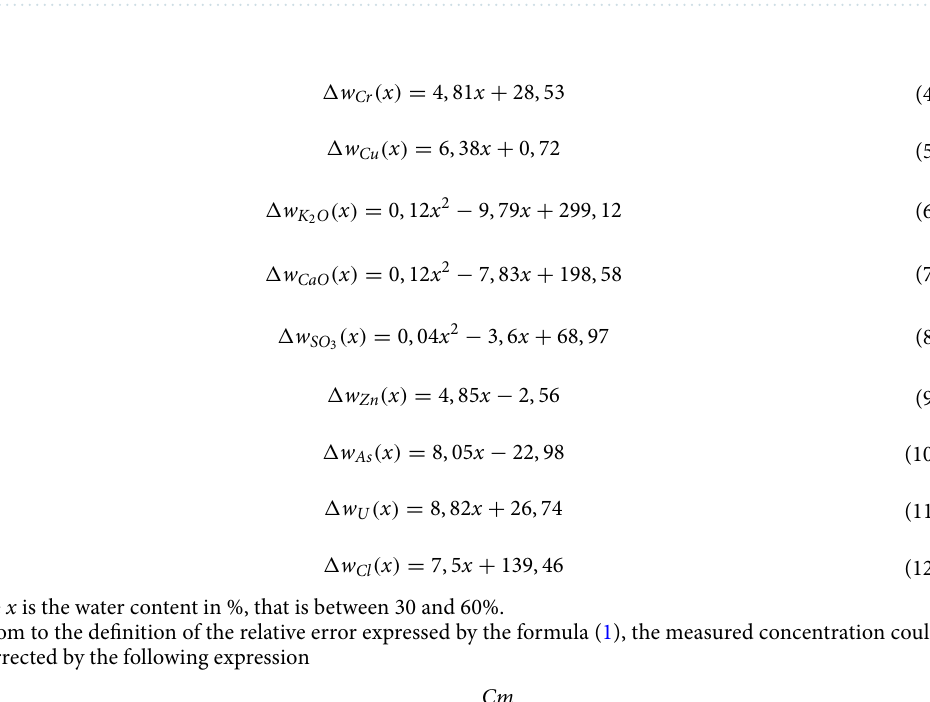
Table 5. The relative error values for the XRF measurements of P 2 O 5 . Significant values are in bold.